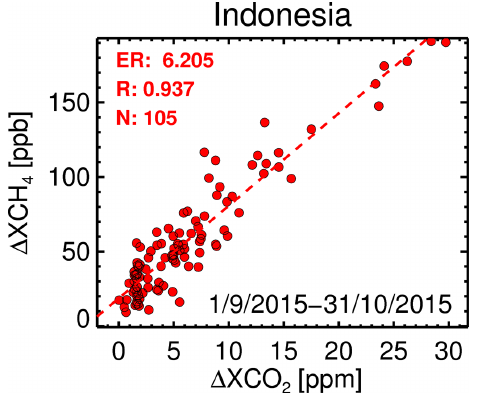
Figure 7. Scatterplot of GOSAT-derived (cid:49) XCH 4 vs. (cid:49) XCO 2 val- ues for large-scale fire plumes seen over Indonesian region (of the type seen in Fig. 4) from 1 September to 31 October 2015, cal- culated as the total column difference between the fire-affected and corresponding clear background TANSO-FTS soundings. The CH 4 / CO 2 ER, (ppbppm − 1 ) is calculated from the gradient of a linear best fit, shown as the dashed line. Also shown are the corre- lation coefficient R and the number of soundings N